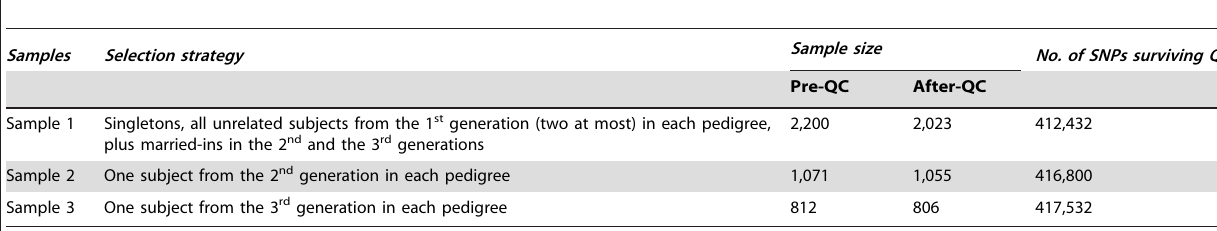
Table 1. Selection strategy and quality control parameters for sub-population construction.